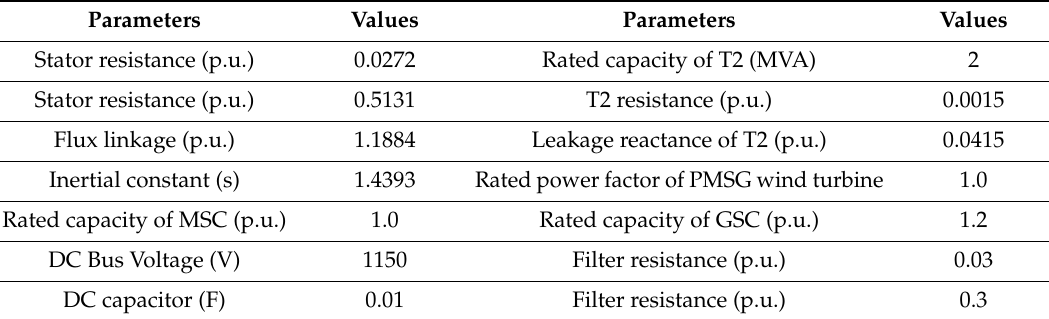
Figure 1. Simulation system. Table 1. Physical Parameters of 1.5-MW PMSG wind turbine.